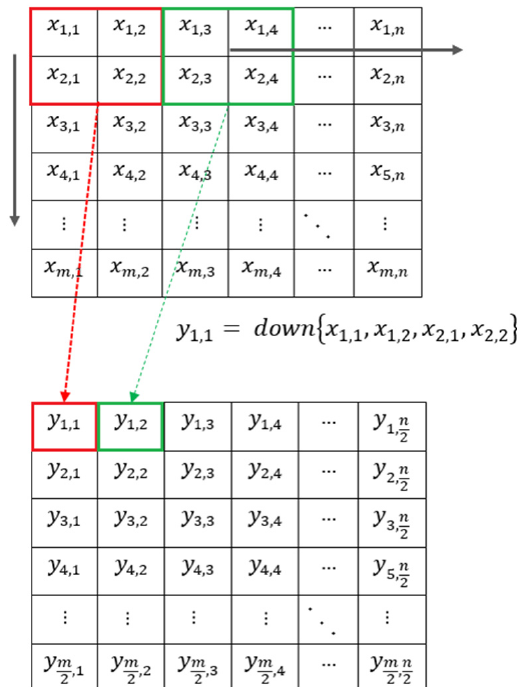
Figure 2. Down-sampling in pooling